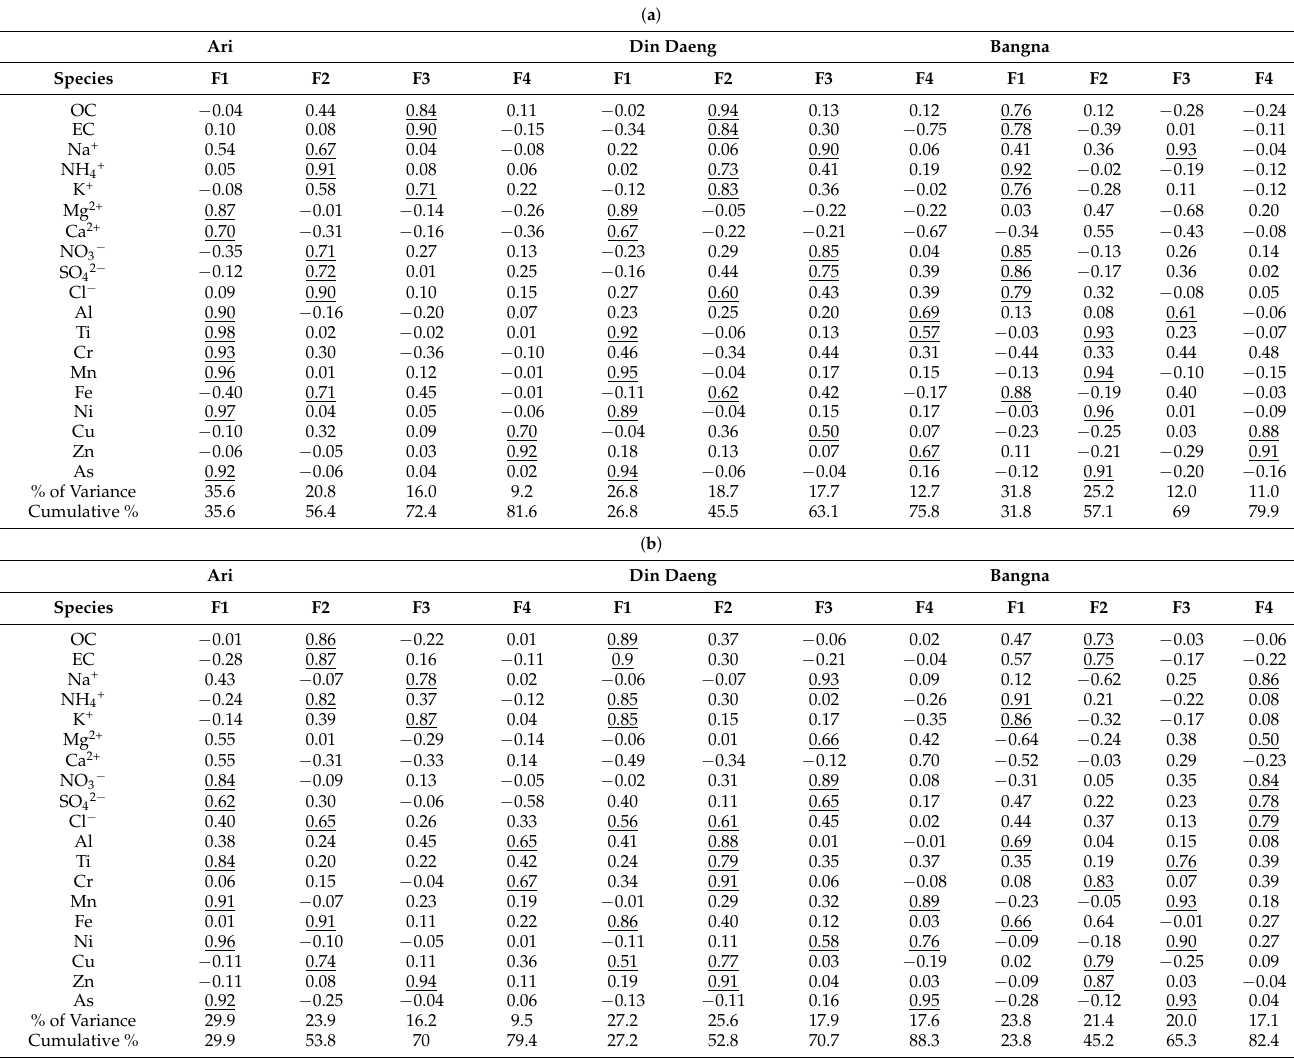
Table 4. ( a ) Principal component analysis for selected species of PM 2.5 at Ari, Dindaeng, and Bangna, Bangkok, Thailand ( b ) Principal component analysis for selected species of PM 10 at Ari, Dindaeng, and Bangna, Bangkok,